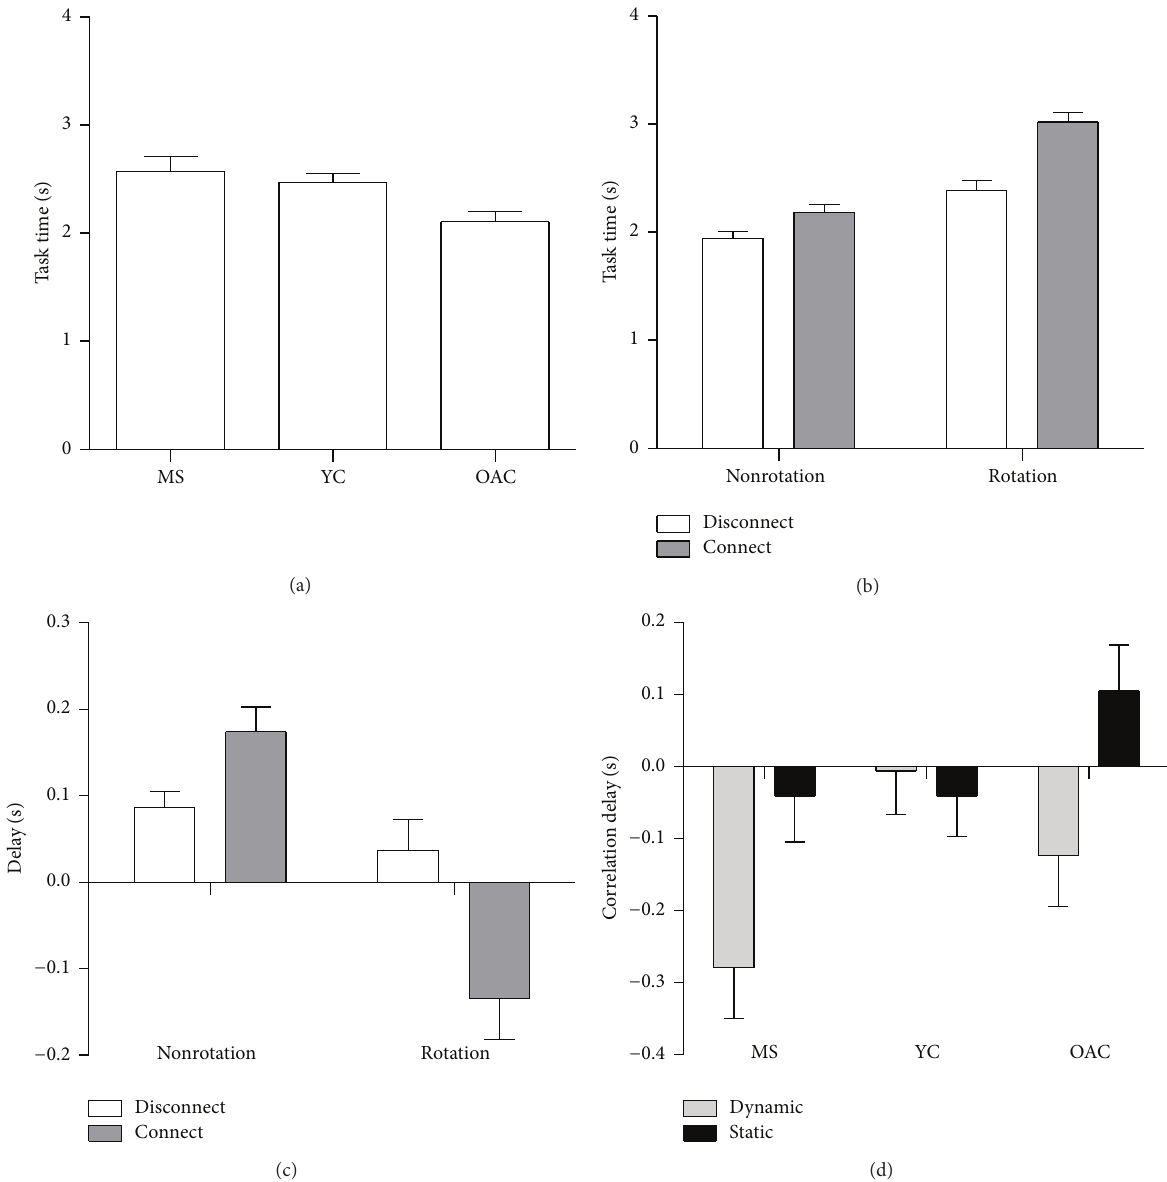
Figure 2: Mean and standard error of task time, force onset delays, and cross-correlation delays. MS: multiple sclerosis group, YC: young control group, and OAC: older adult control group. (a) Task time for each of the three diagnosis groups. (b) Task time across all three groups during rotational and nonrotational actions. (c) Force onset delays across all three diagnosis groups during rotational and nonrotational actions. (d) Cross-correlation delays for each of the three diagnosis